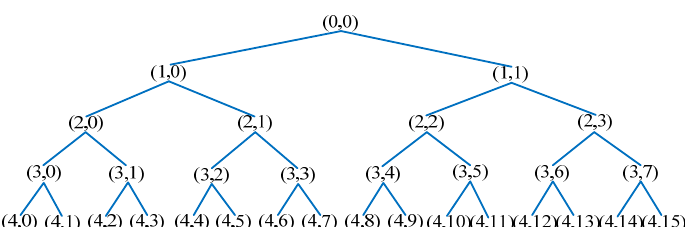
Figure 5. Wavelet packet decomposition tree of four